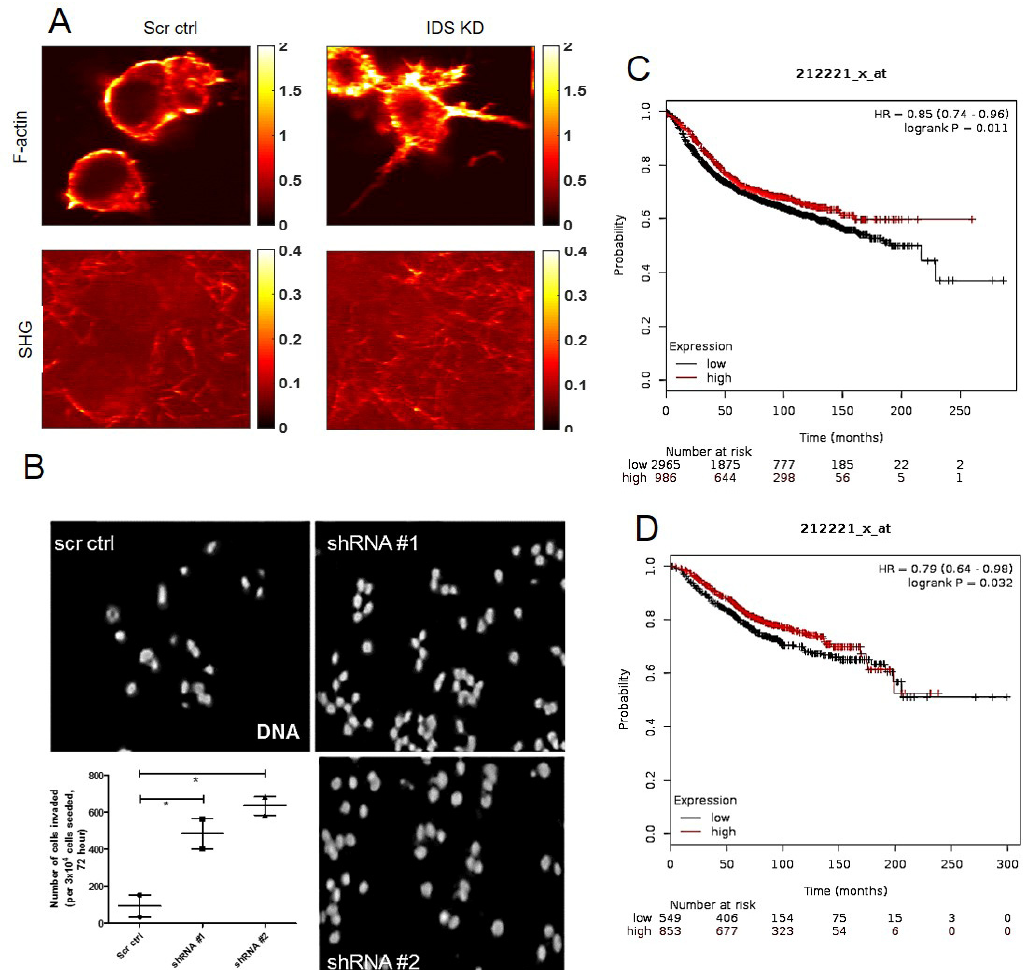
Figure 4. Low levels of IDS increase invasion of MCF-7 and correlate with poorer prognosis of breast cancer patients. ( A ) Two photon micrographs of MCF-7 control cells (left) and with IDS knockdown (right) showing phalloidin staining of actin cytoskeleton (top) and second harmonic generation signals (bottom), scale = 10 µ m. ( B ) Epifluorescence micrographs of the invasion of MCF-7 cells stained for DNA (using DAPI), lentivirally transduced with scrambled shRNA and 2 shRNA clones against IDS through transwells coated with Type 1 collagen. DAPI was used as indicator of invaded cells. Graphical representation of the number of invaded cells shown in 4B. ( C , D ) Kaplan–Meier plots of risk-free survival and overall survival, respectively, reveal a significant correlation between higher IDS expression and better survival (lines in graphs represent mean ± SE of 2–3 independent experiments). Significance was measured using one-way ANOVA (* p < 0.05).